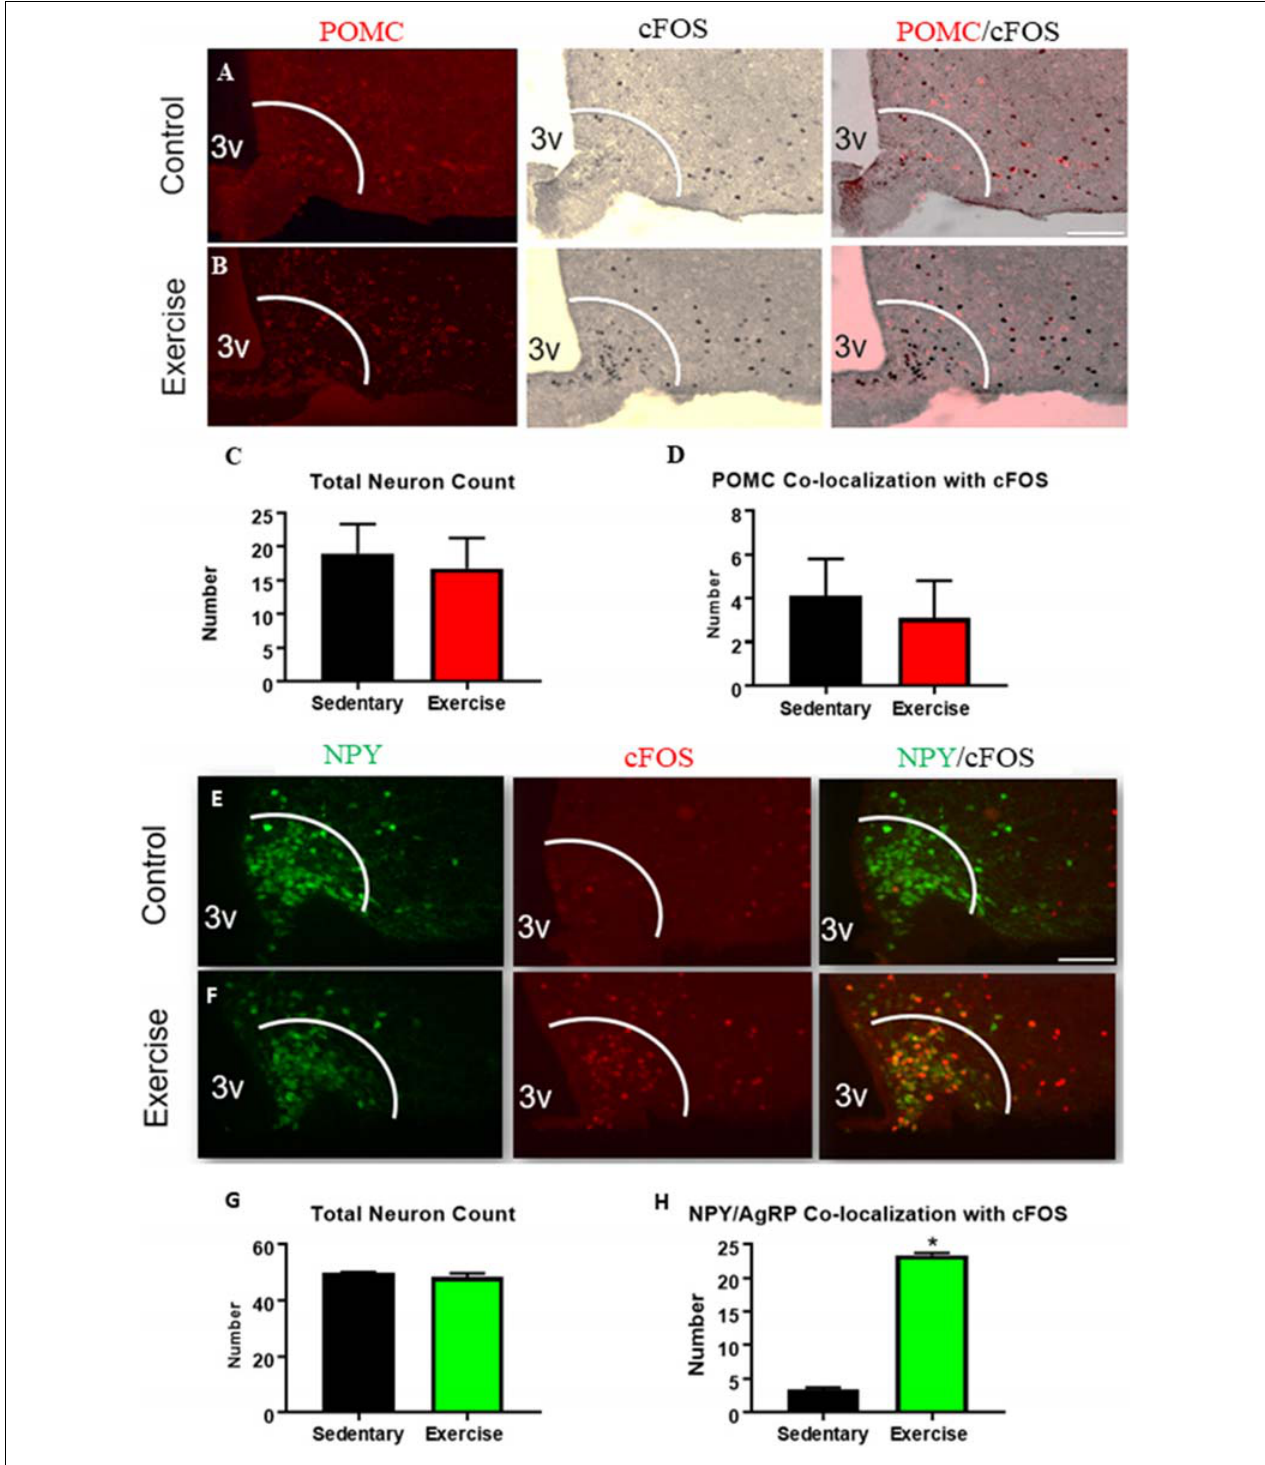
FIGURE 1 | An acute bout of exercise increases ARC AgRP / NPY neuron activation while ARC POMC neuron activation remains unchanged. Expression of cfos in POMC-expressing neurons in ARC sections from (A) sedentary control and (B) exercise groups immediately after an acute bout of exercise. (C) Average POMC neuron count per slice. (D) Average number of neurons that are co-localized with cfos. Expression of cfos in ARC AgRP / NPY neurons in (E) sedentary control and (F) exercise groups immediately after an acute bout of exercise. (G) Average ARC AgRP / NPY neuron count per slice (H) ARC AgRP / NPY neuron’s that are co-localized with cfos. 3V: third ventricle; scale bars represent 50 µ m. Bar graphs show Mean + SEM. ( N = 6 male mice per group), * indicates p < 0.05 vs. sedentary group.